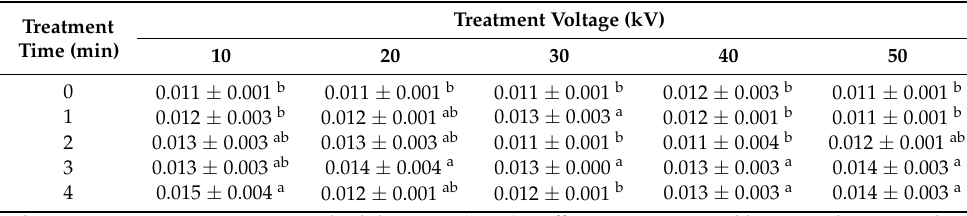
Table 4. Effect of ACP on total sulfhydryl of purified